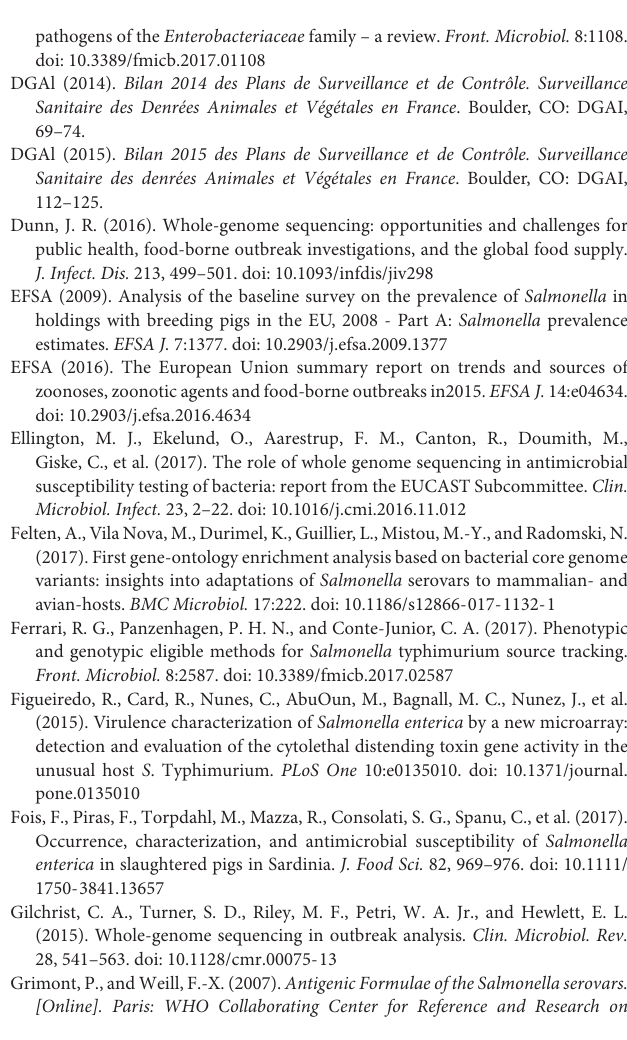
TABLE S2 | List of the genomes from different serotypes of Salmonella enterica subsp. enterica used for the FimH sequence analysis. Epidata and sample ID. TABLE S3 | List of strains presenting antimicrobial resistance